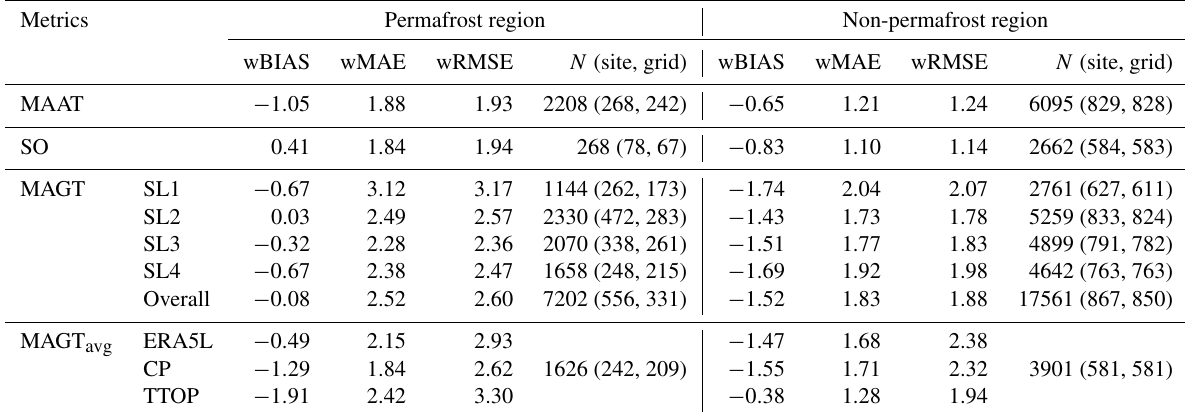
Table 2. Comparison of ERA5L with observations and published data products for mean annual air temperature (MAAT), mean annual ground temperature (MAGT) of different soil layers, and surface offset